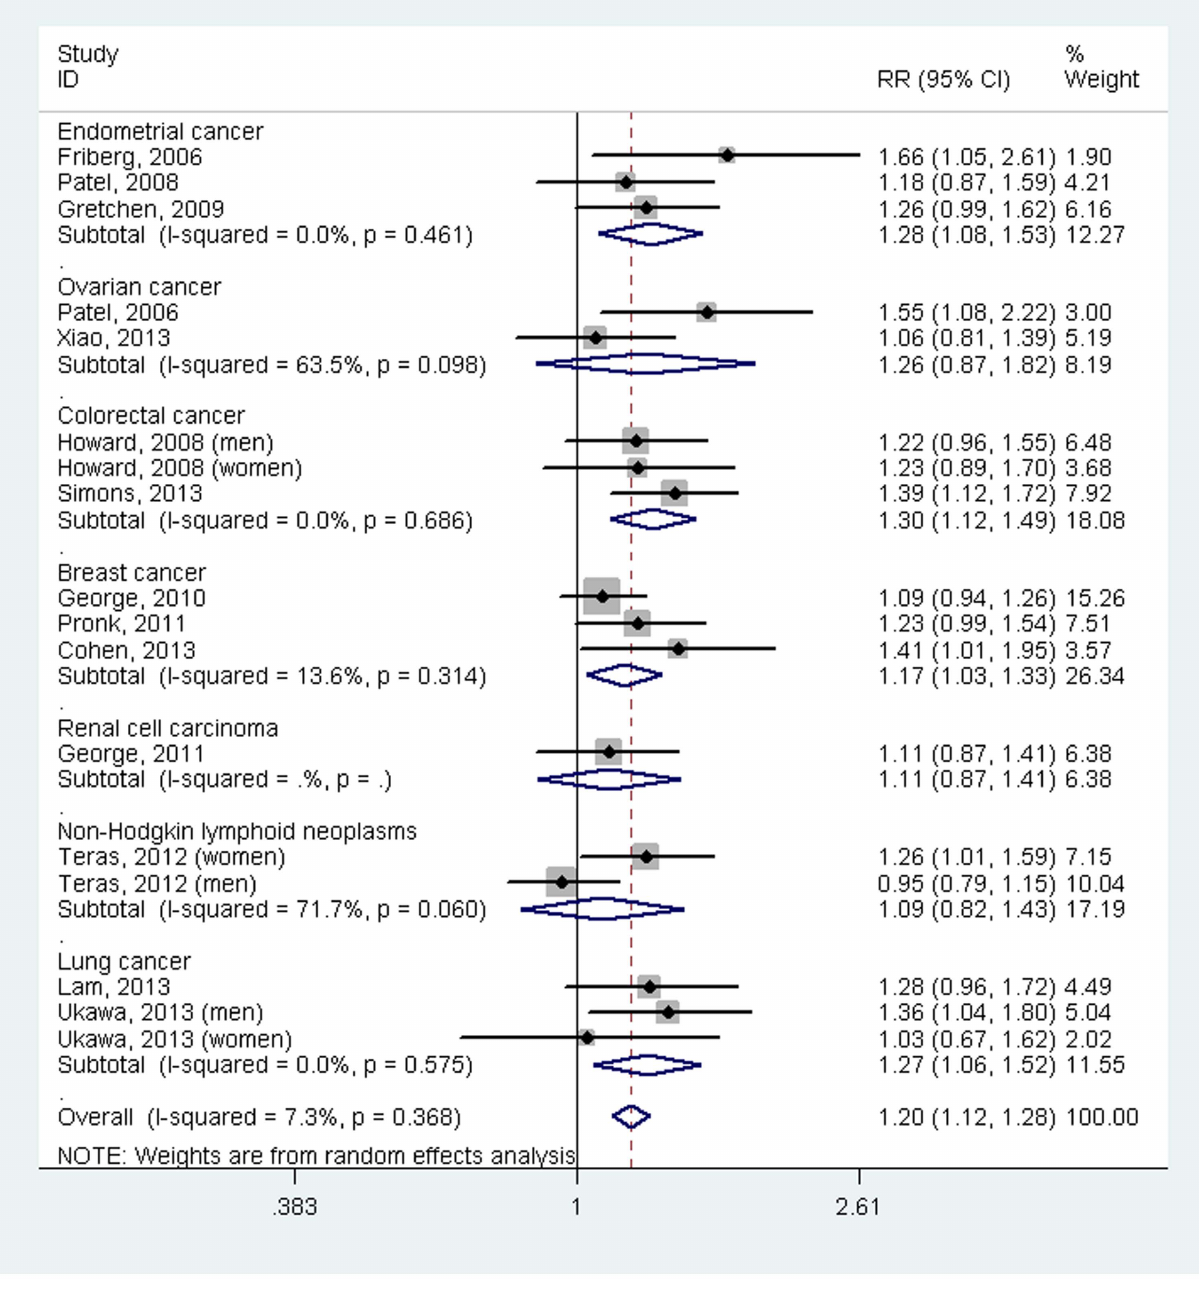
Figure 3. Forest plot of the association between sedentary behavior and risk of incident cancer by cancer site (highest versus lowest